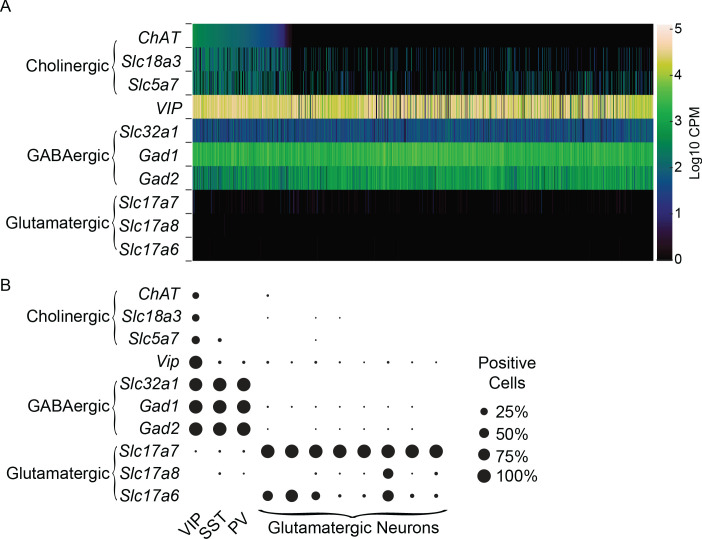
A subset of VIP+ interneurons express cholinergic genes by single-cell RNA sequencing.(A) Heat map of the number of transcripts per cell (log counts per million, Log10 CPM) for various neurotransmitter synthesis and vesicular release machinery genes from 2952 single-cell transcriptomes of Vip-expressing neurons from visual cortex and anterior lateral motor cortex. Cells are ordered from left-to-right according to their expression of Chat. Data is downloaded from the Allen Brain Institute’s RNA-Seq Data Navigator, accessible at: http://celltypes.brain-map.org/rnaseq/mouse. (B) The proportion of cells in different cell sub-types that are positive for different transcripts for genes indicating different neurotransmitter phenotypes, as defined by >1 log10 CPM of each transcript.